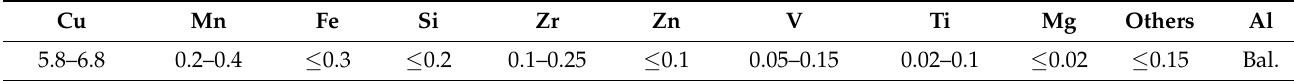
Table 1. Chemical composition of 2219 aluminum alloy (wt.%).